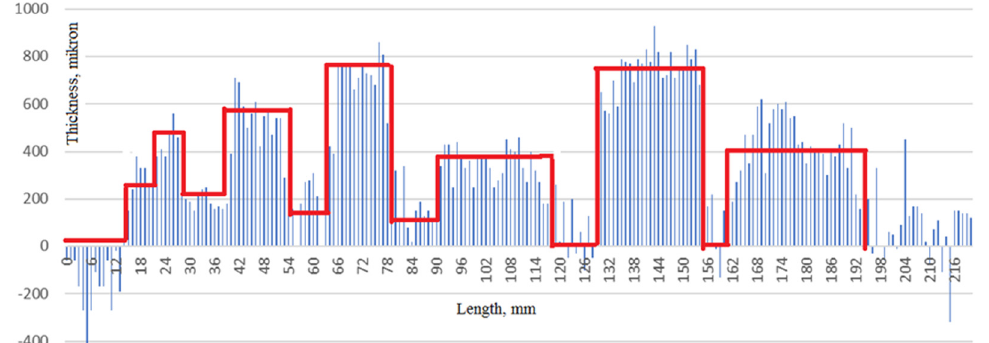
Figure 8. Desired graph for measuring the profile of the material thickness.